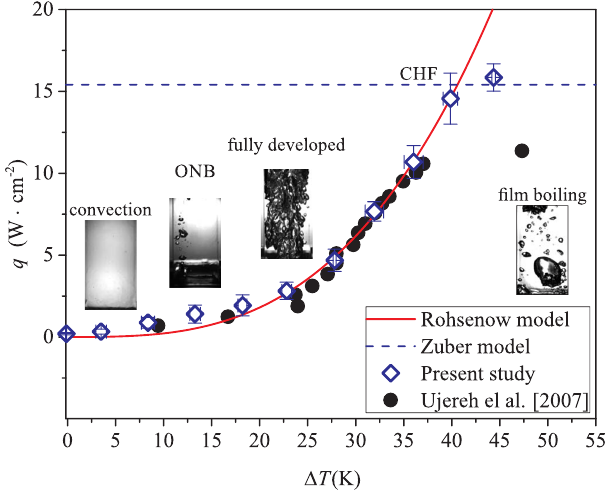
Figure 5. Comparison between the boiling curve measured on silicon smooth surface in the present study and the one obtained by Ujereh et al . 42 . The solid line represents the heat flux predicted by Rohsenow model, and the dashed line represent the critical heat flux predicted by Zuber model 37